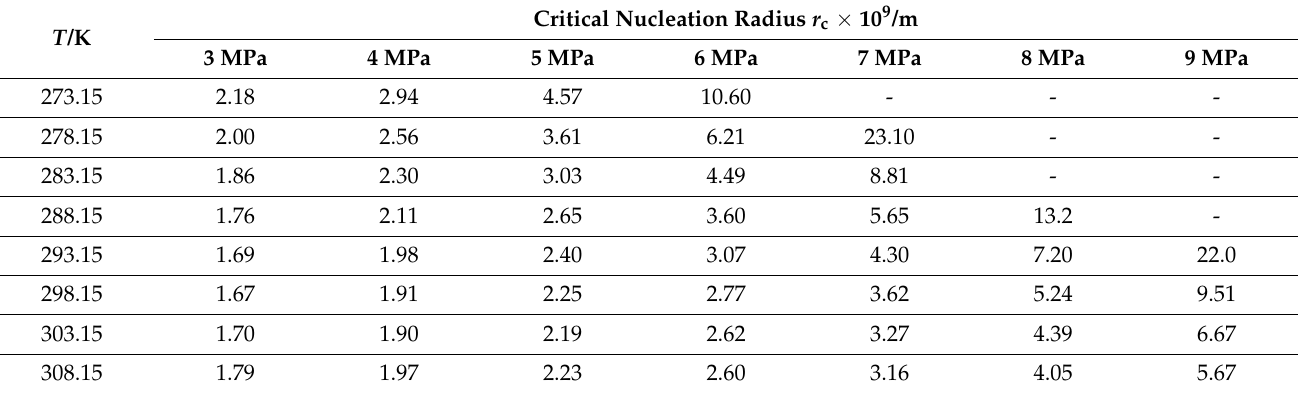
Table 4. Calculation results of critical nucleation radius of elemental sulfur in gas 3.